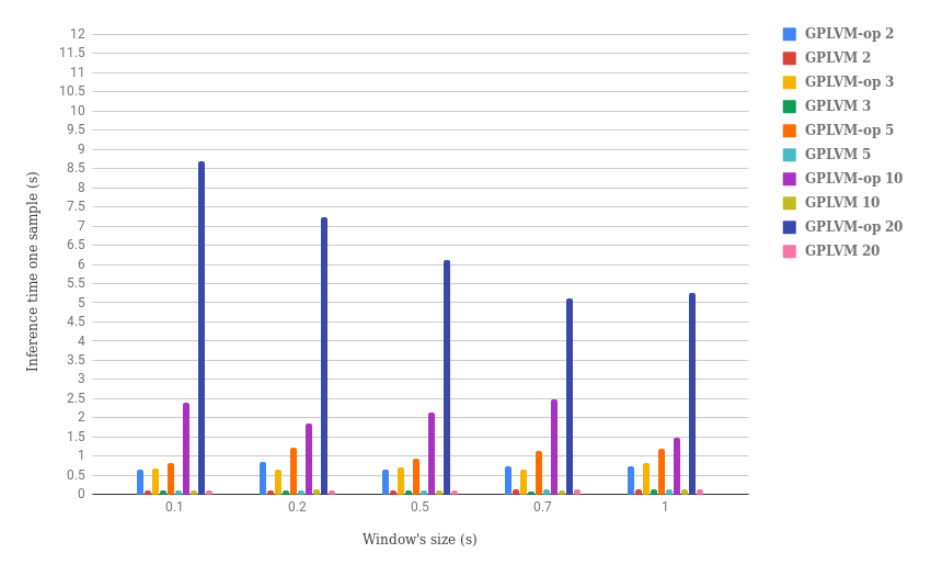
Figure 11. Graphical representation of the inference time per sample for the different types of feature based classification (optimized and non-optimized GPLVM inference), sampling window’s size (0.1, 0.2, 0.5, 0.7, and 1.0 s), and number of latent variables (2, 3, 5, 10, and 20). GPLVM-op leads to longer inference time than GPLVM, which also applies when the number of latent variables